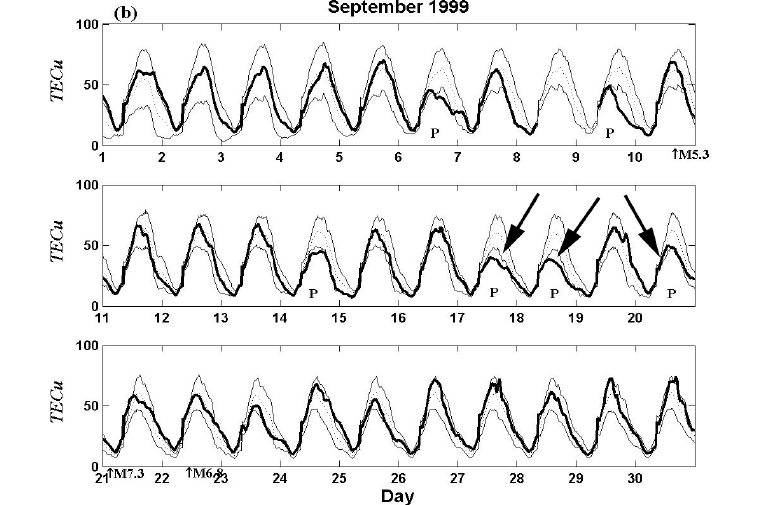
Figure 20. The variations of TEC observed in September 1999 for the Chi-Chi earthquake (M = 7.6, 20 September 1999, Taiwan). 1 TECu = 10 16 el/m 2 . Arrows show TEC anomalies